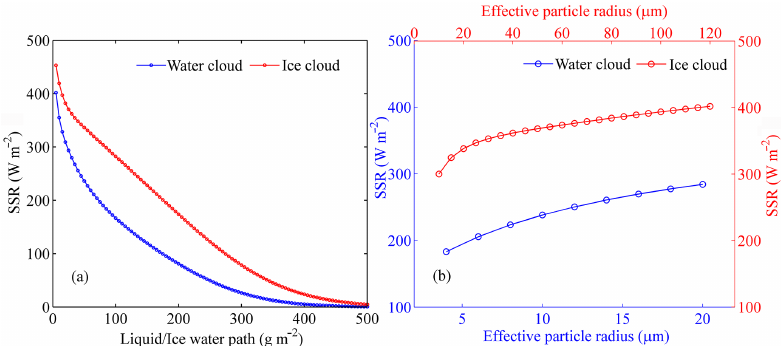
Figure 5. (a) Sensitivity of SSR to cloud liquid/ice water path, given the effective particle radius for water cloud and ice cloud of 12 and 30µm, respectively. (b) Sensitivity of SSR to cloud effective particle radius for water cloud and ice cloud, given liquid/ice water path of 80gm − 2 .